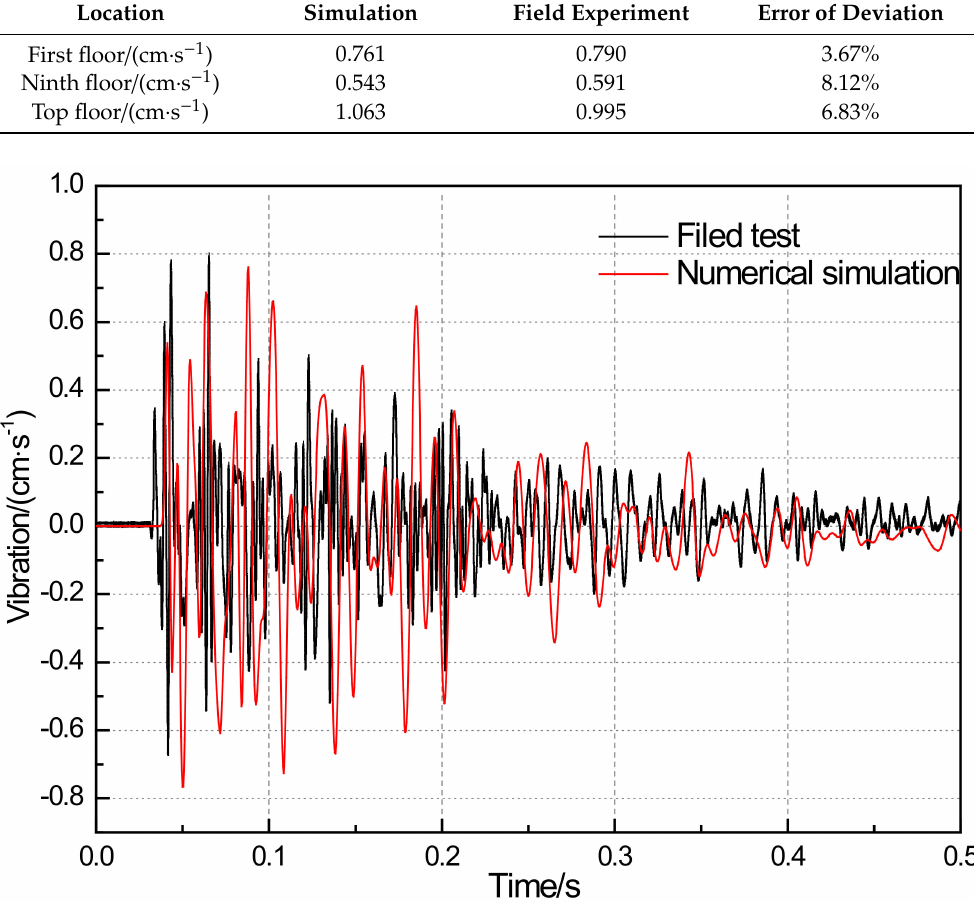
Figure 7. Vibration velocity curves of numerical simulation and field